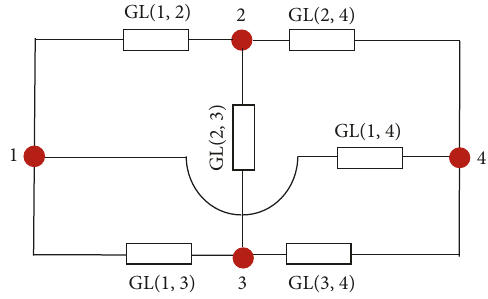
Figure 12: Complementary